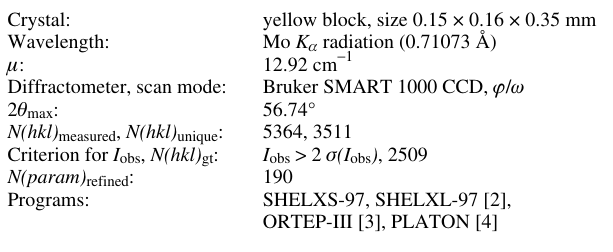
Table 1. Data collection and handling.